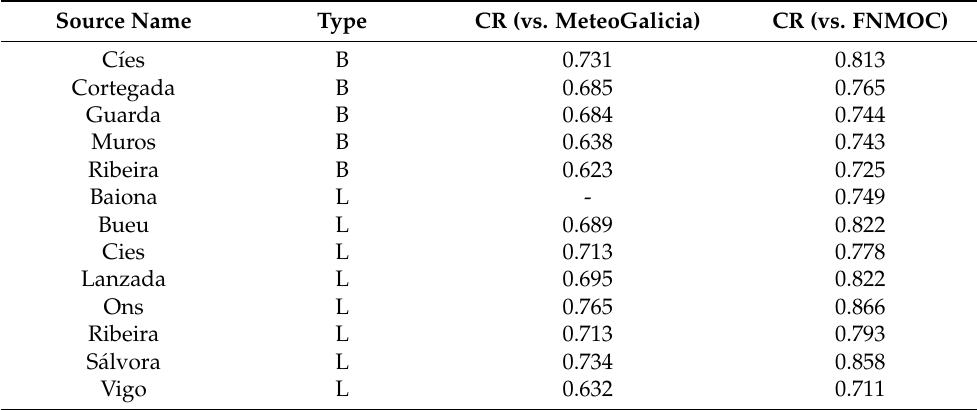
Table 3. Concordance ratios for each source and the two reference numerical